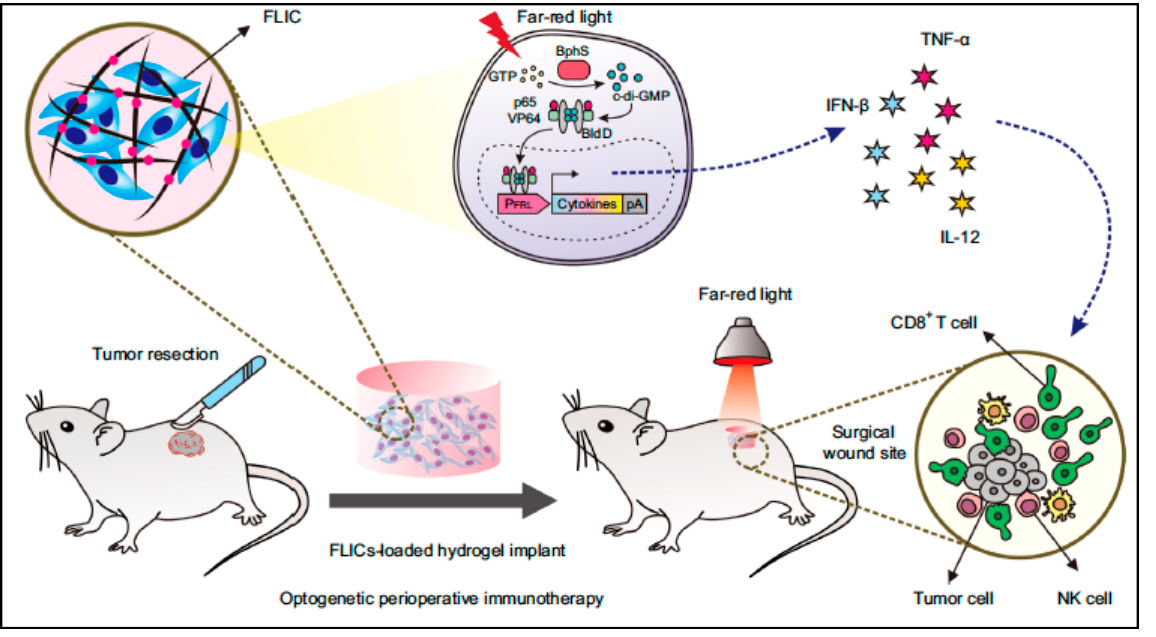
Figure 8. Schematic representation of the in vivo experimental setup for optogenetic perioperative immunotherapy using hydrogel implants loaded with far-red light-controlled immunomodulatory engineered [125]. Copyright CC BY 4.0.